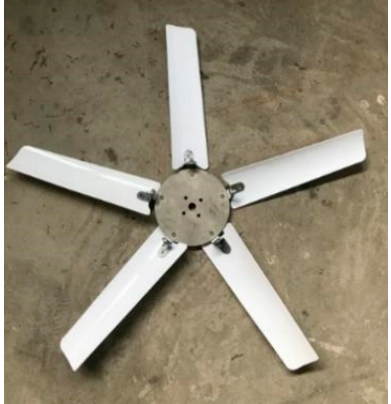
Figure 2. Photo of forward curved fan blades.